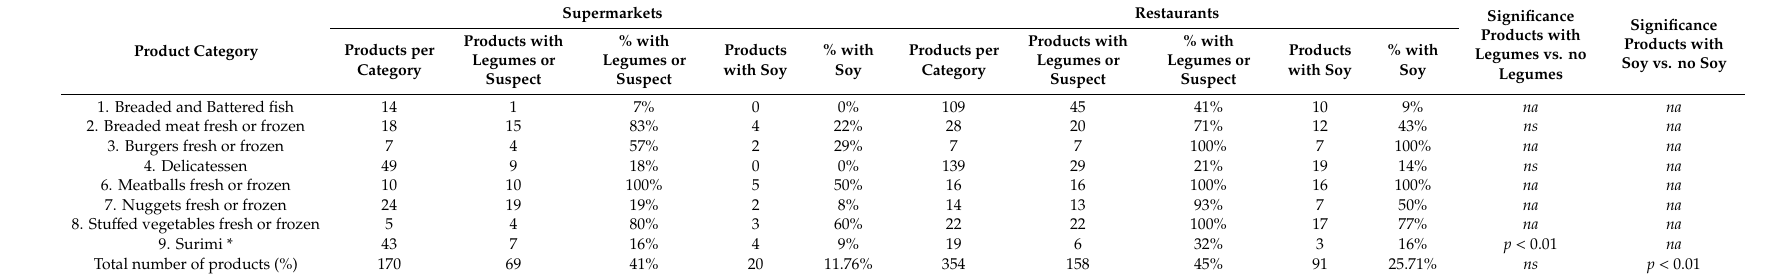
Table 2. Comparison between the o ff ers of the processed food claiming to contain pulses in the two distribution circuits.